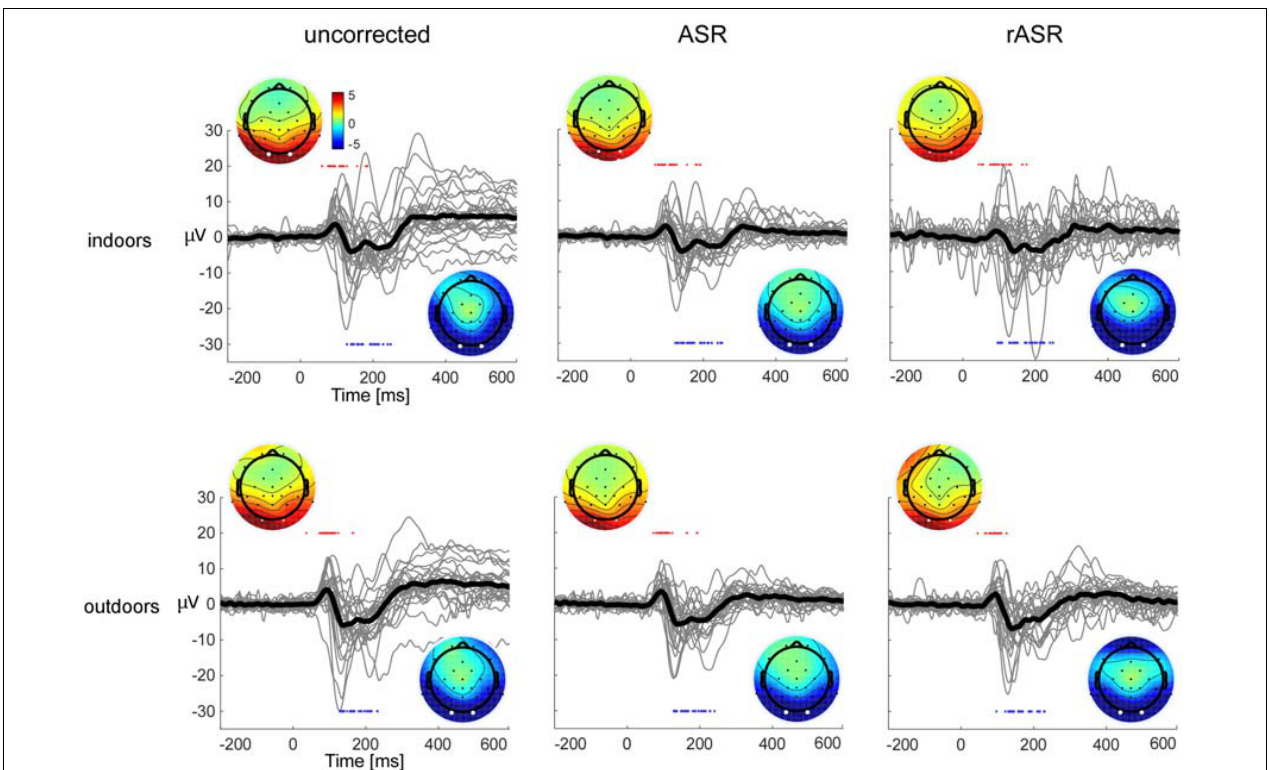
FIGURE 2 | Single subject (gray lines) and grand average (black lines) visual-evoked potentials, shown for uncorrected data (left) and following correction with ASR and rASR (center column and right). VEPs are shown for indoors and outdoors data and show the arithmetic mean of occipital channels O1 and O2, referenced to a central reference near Cz. The voltage maps show the averaged single subject topographies at subject-specific latencies for the early P1 and the later N1 response, all topographies are scaled identically. Individual latencies are indicated by red (P1) and blue (N1) dots. In the uncorrected data, one channel (right temporal T8) was interpolated for the voltage